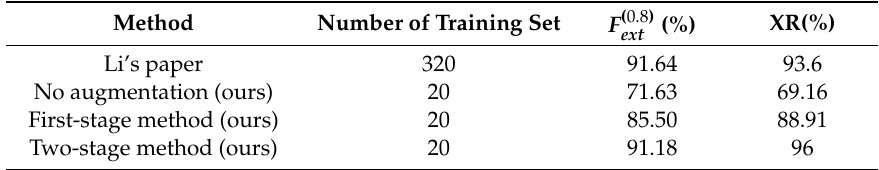
( 0.8 ) Table 6. F and extended recall (XR) of di ff erent methods of crack ext